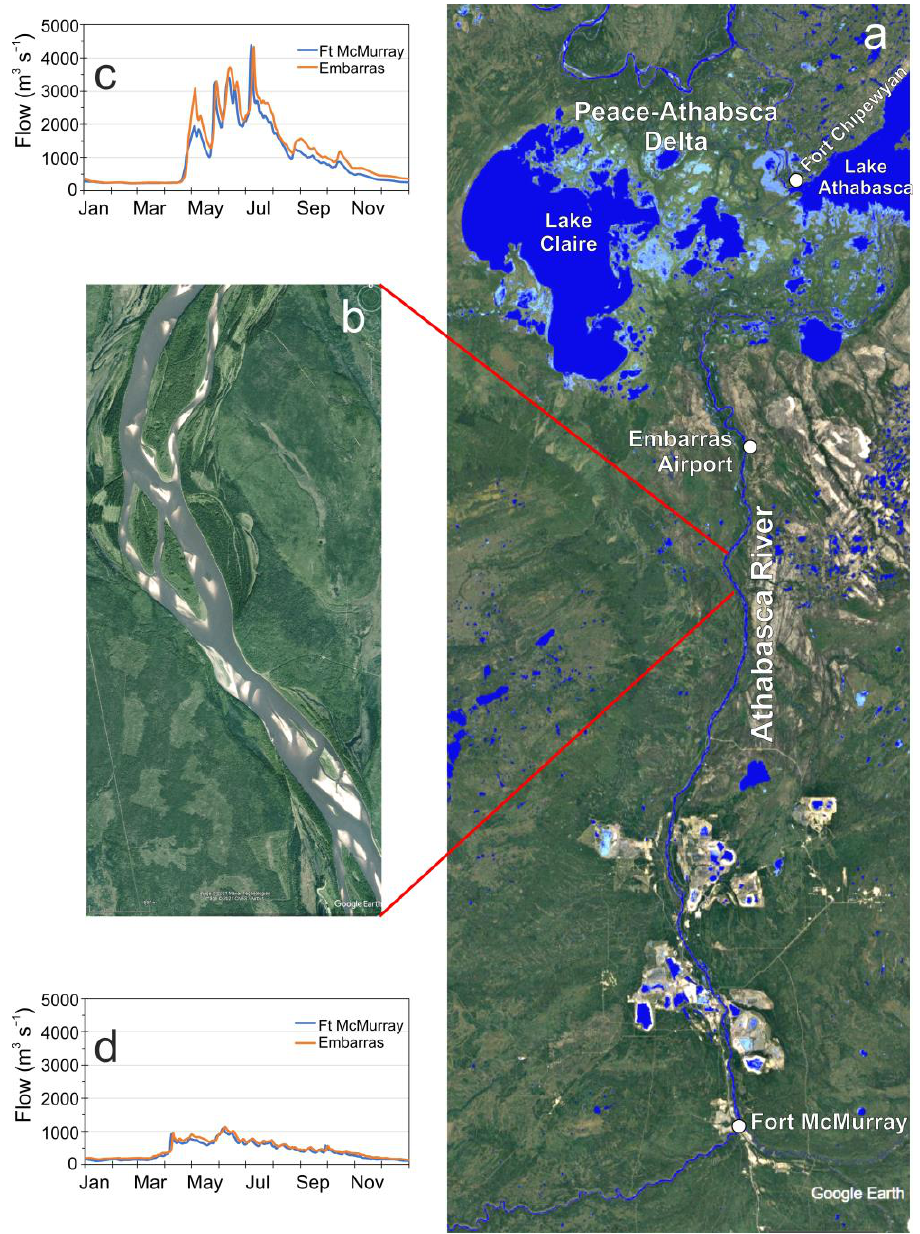
Figure 2. ( a ) Lower Athabasca River mainstem from Fort McMurray to Embarras Airport to Lake Athabasca and the Peace–Athabasca Delta system. Examples of ( b ) islands, mid-channel bars, and sand bars; ( c ) a high summer flow year in 2020; and ( d ) a low summer flow year in 2015.